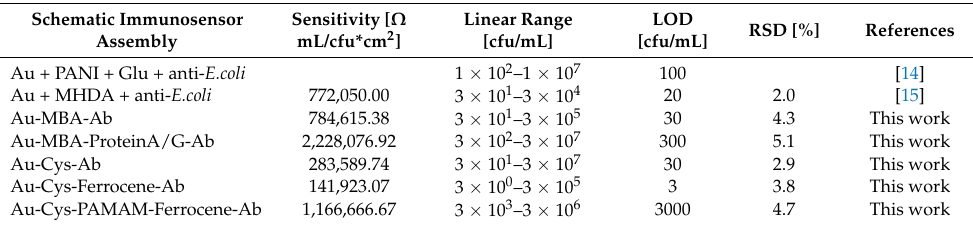
Table 1. Comparing study between the present work with some recent impedimetric label—free immonosensors for E. coli O157:H7 detection.